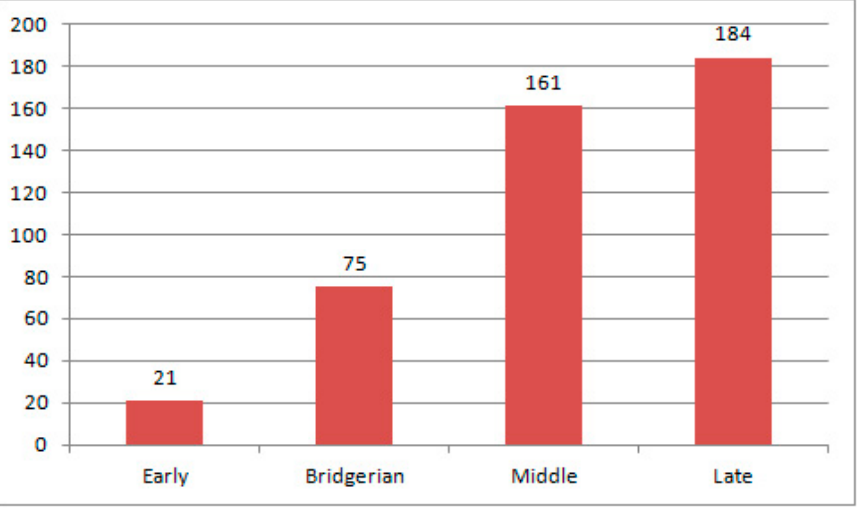
Figure 19. Change in the number of Curculionoidea species in the Eocene.